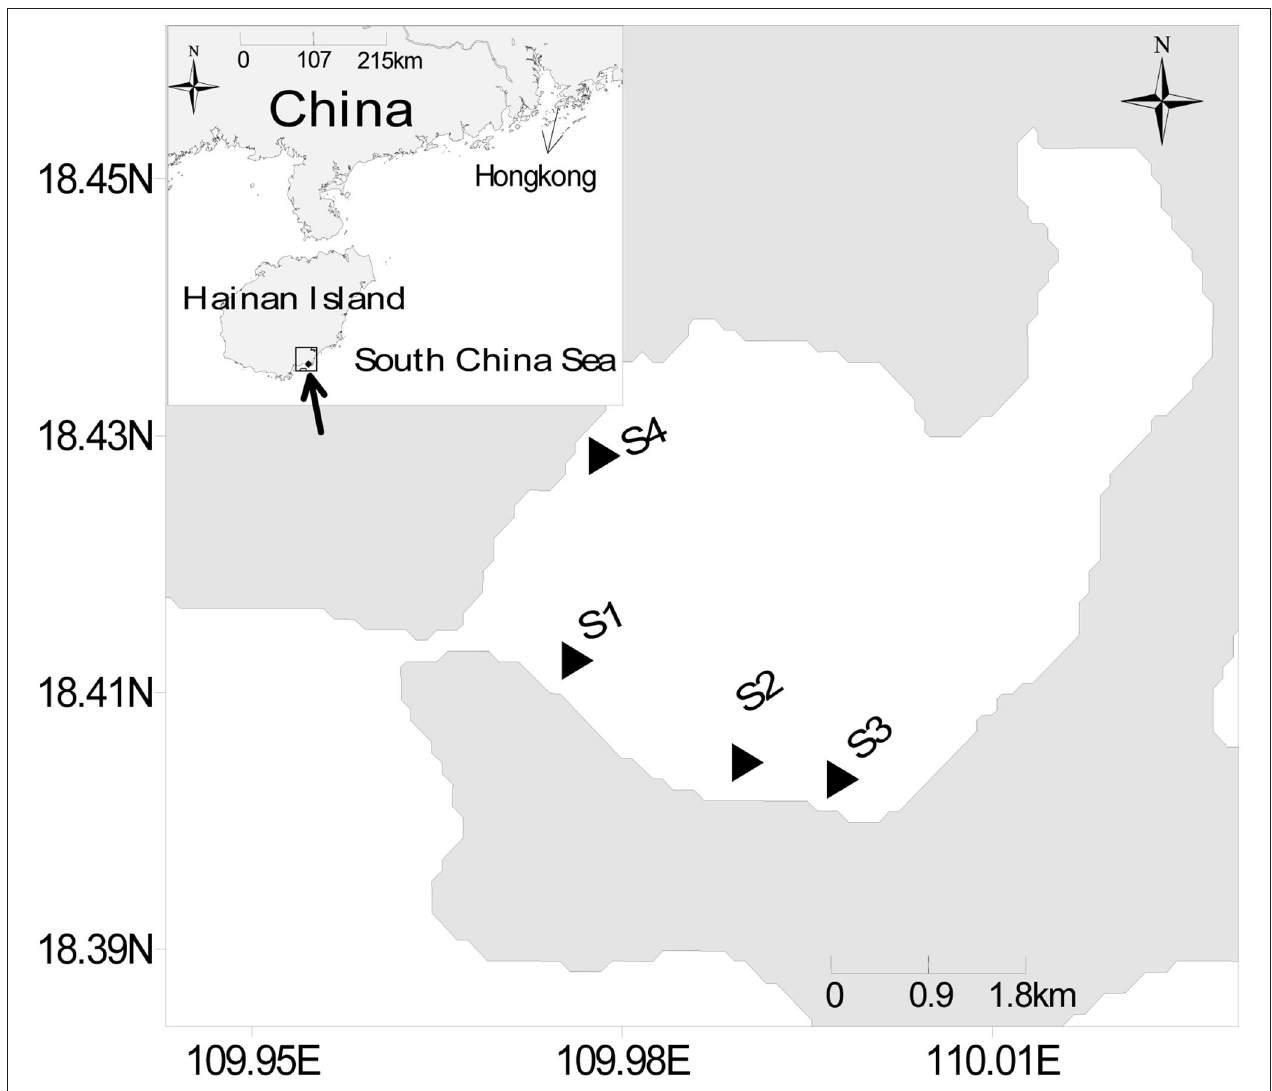
FIGURE 1 | Sample sites in Xincun bay, Hainan island, South China